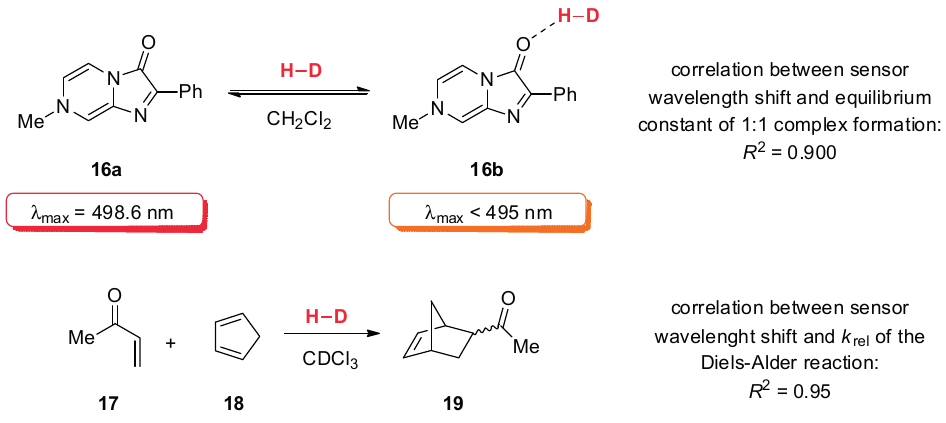
Figure 4. UV-Vis sensor and the correlation between sensor wavelength shift and sensor-catalyst binding equilibrium constant.